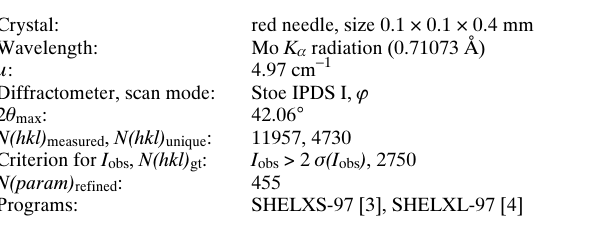
Table 1. Data collection and handling.